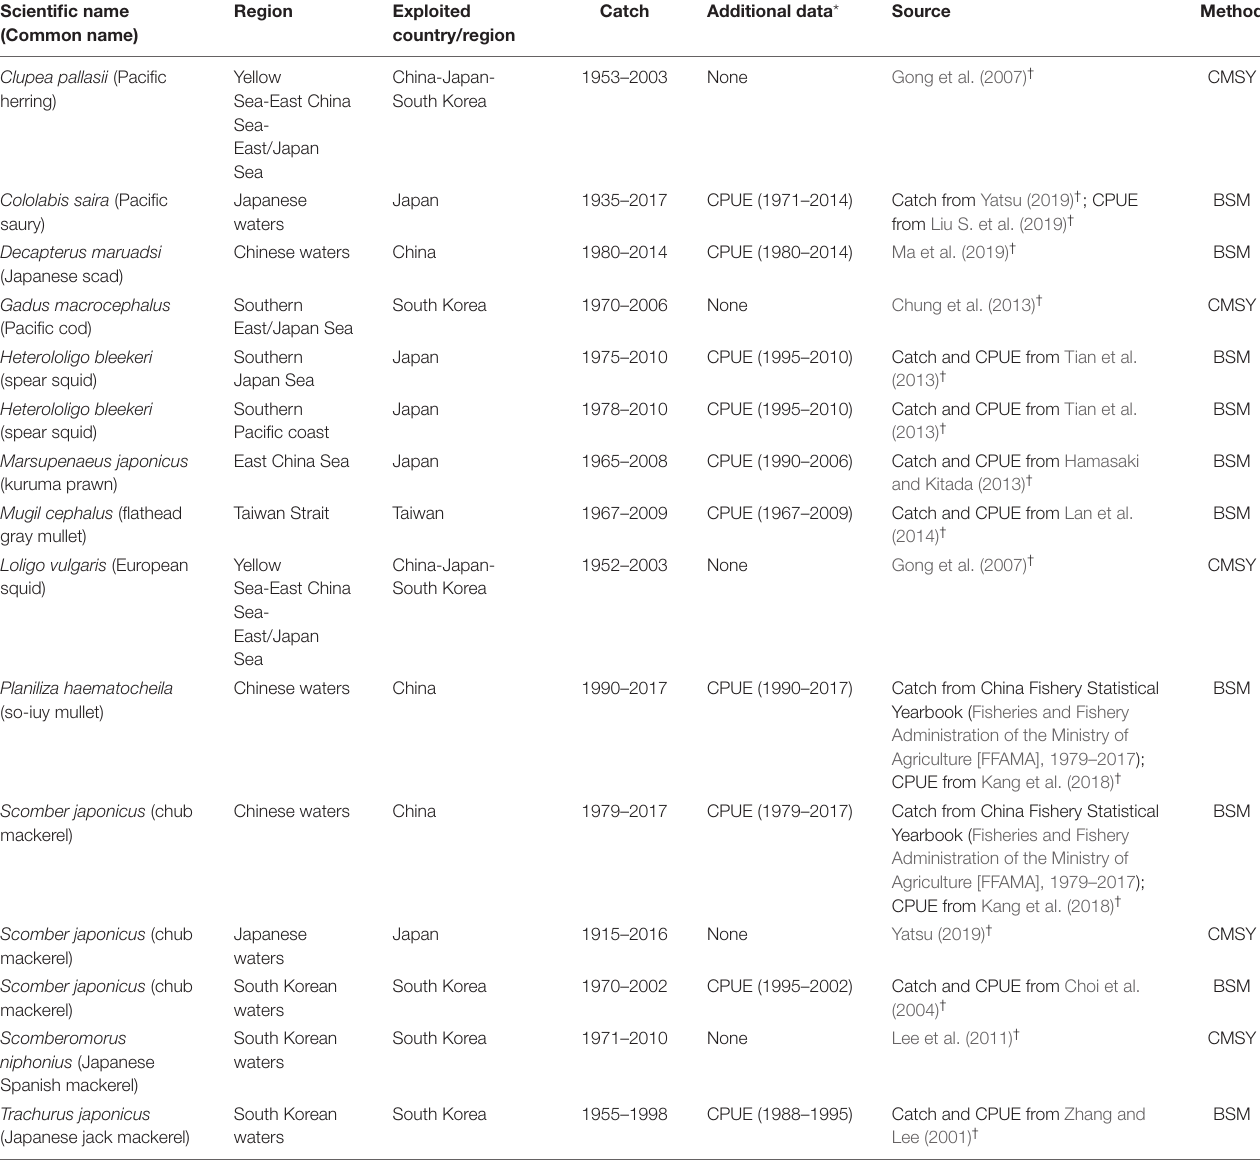
TABLE 1 | Summary of data available for the stock assessments presented here.